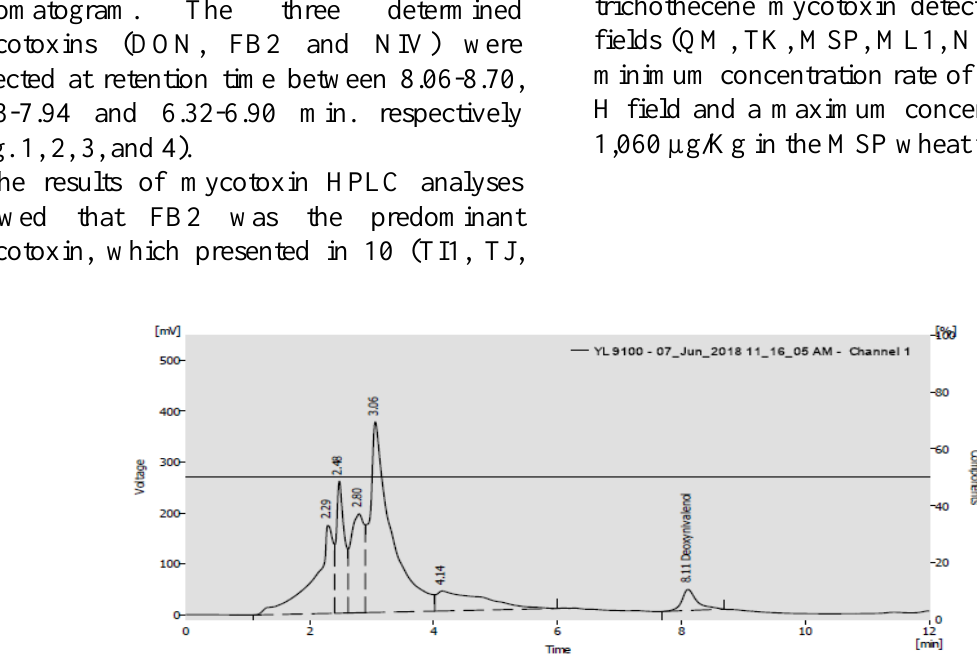
Figure, 1: HPLC chromatogram presented peak detection by absorbance at l = 220 nm and peak spectra for Deoxynivalenol (DON) concentration in wheat seeds in ppm/ 5gm.